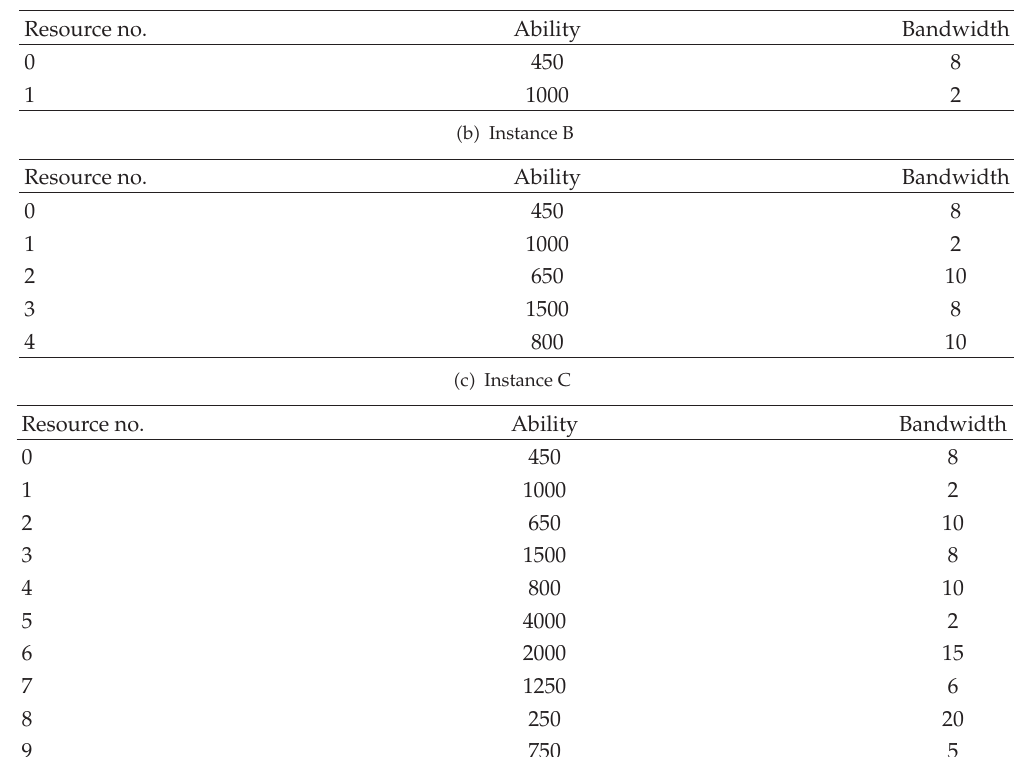
Table 12: Three instances of